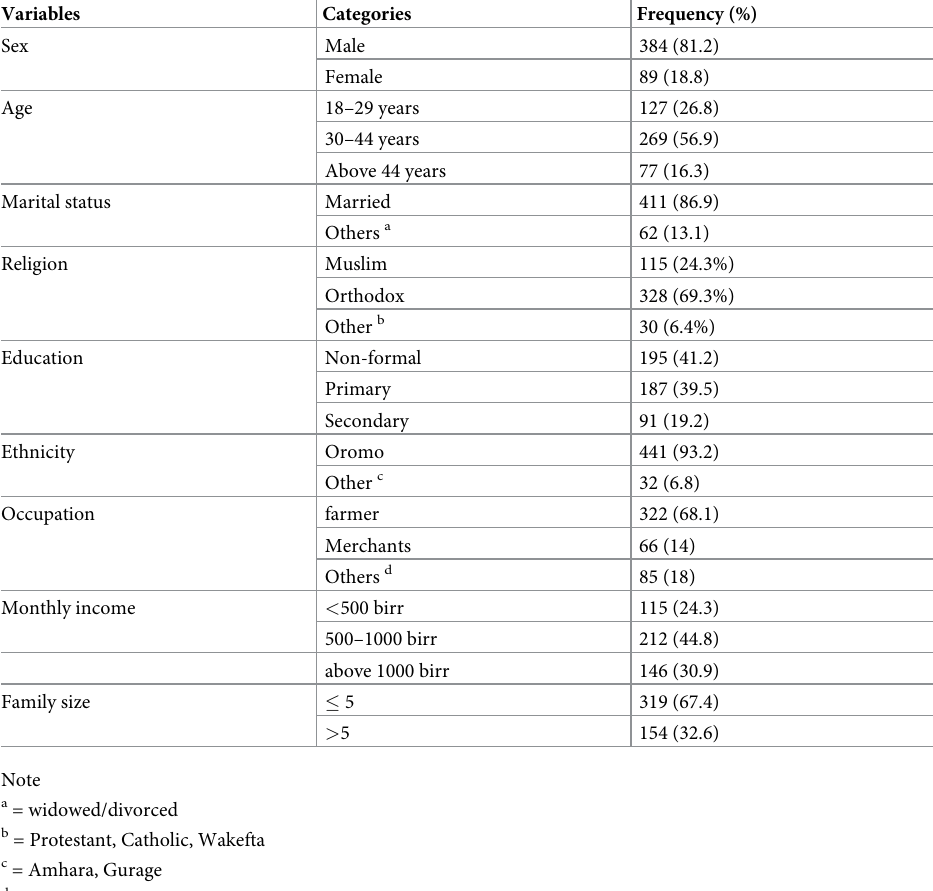
Table 1. Sociodemographic characteristics of respondents in South Central, Ethiopia,